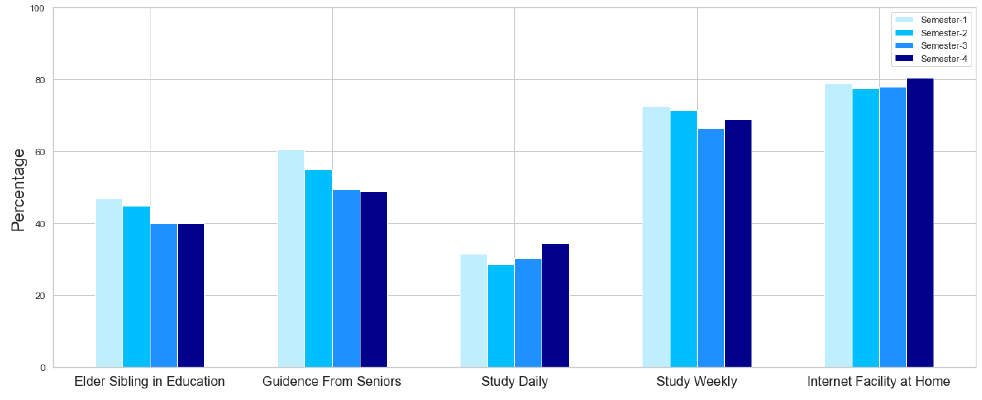
Figure 3. Semester-wise Behavioral features of Students